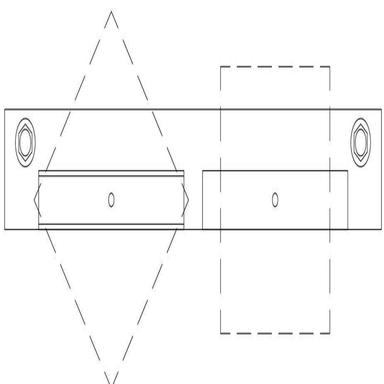
The U-profiles on the support for the "45 configuration" (left) and the "90 configuration" (right), with the central point where the magnets were fixed.